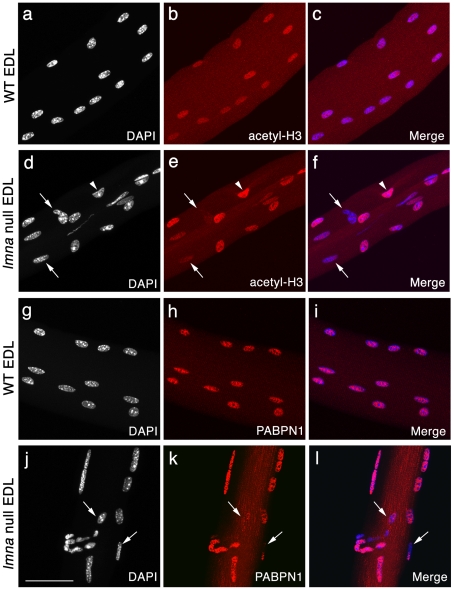
Variable transcriptional activity and mRNA processing between myonuclei of lmna-null mice.Representative images of wild-type (WT) lmna+/+ EDL myofibres, immunostained for acetyl-histone H3 (red) and counter-stained with DAPI (white), with merged images (a–c). Myonuclei in WT myofibres have near uniform acetyl-histone H3 immunostaining, suggesting similar transcriptional activity. By contrast, immunostaining of lmna
−/− EDL myofibres showed that myonuclei clearly have varying acetyl-histone H3 levels, indicating heterogeneous transcriptional activity, with some immunostaining at near background levels (d–f - arrows) while others appear hyperacetylated (d–f - arrowhead). WT myonuclei also show virtually homogeneous PABPN1 immunostaining (g–i), while in many myonuclei of lmna
−/− EDL, PABPN1 is either reduced, or absent (j–l - arrows). Scale bar 50 µm.